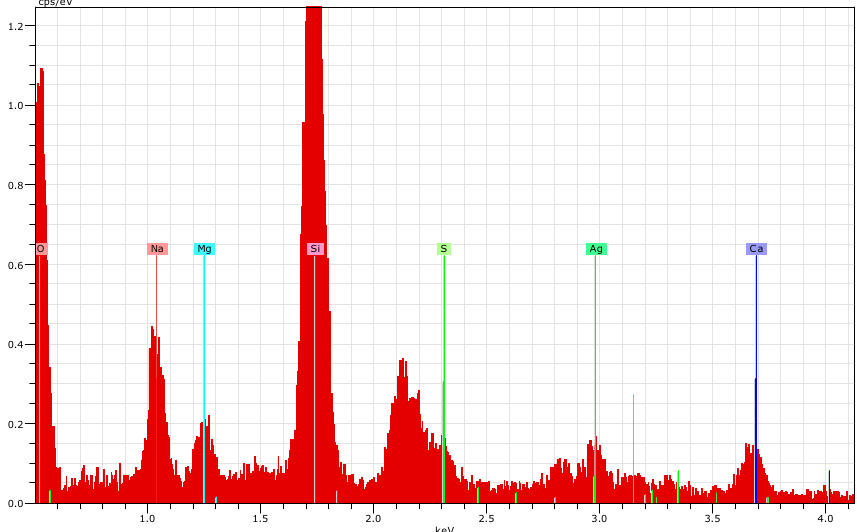
Figure 12. EDX analysis of the reflector silver layer after of 910 h of Kesternich test.